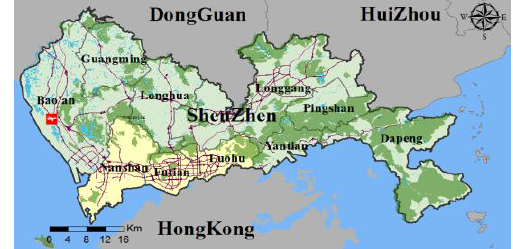
Figure 1. Shenzhen administrative map